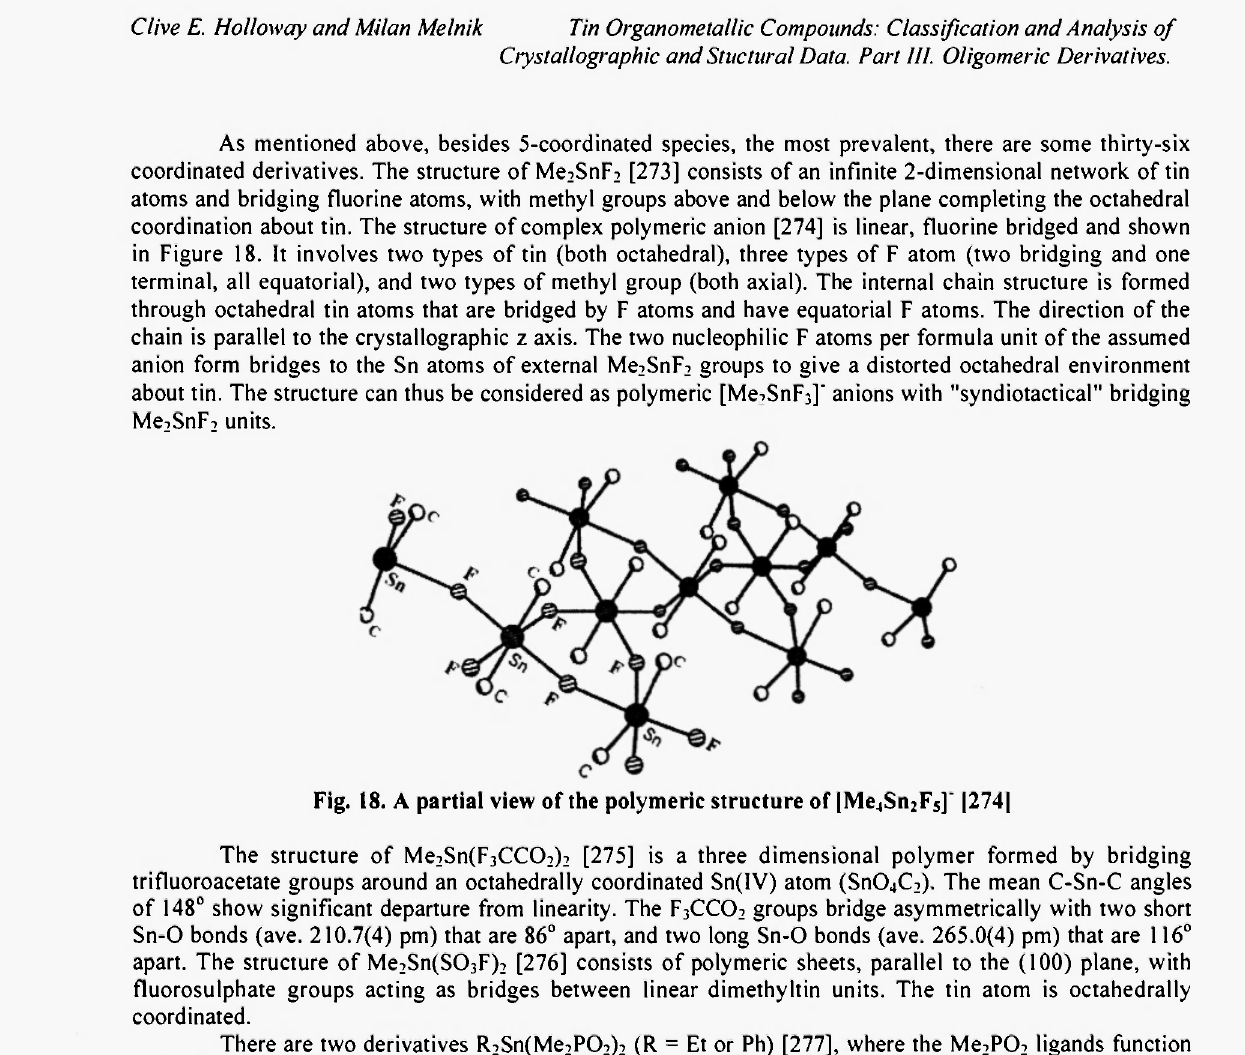
Fig. 18. A partial view of the polymeric structure of |Me 4 Sn 2 F5]"